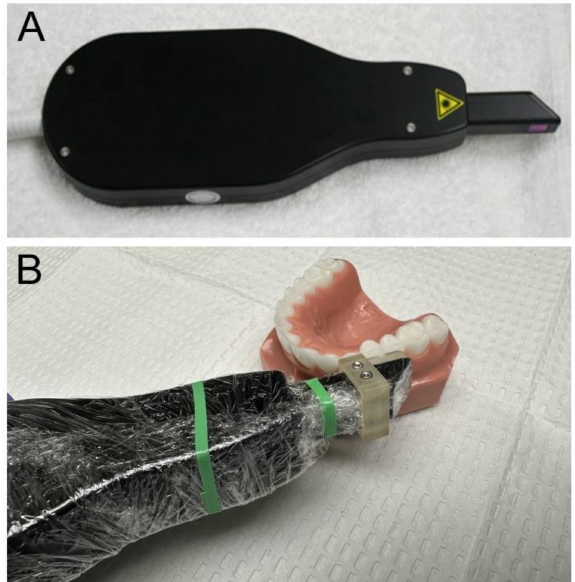
Figure 1. ( A ) CP-OCT handpiece used for these studies, and ( B ) a closeup of the handpiece with the added 3D printed attachment and covered by polypropylene wrap for infection